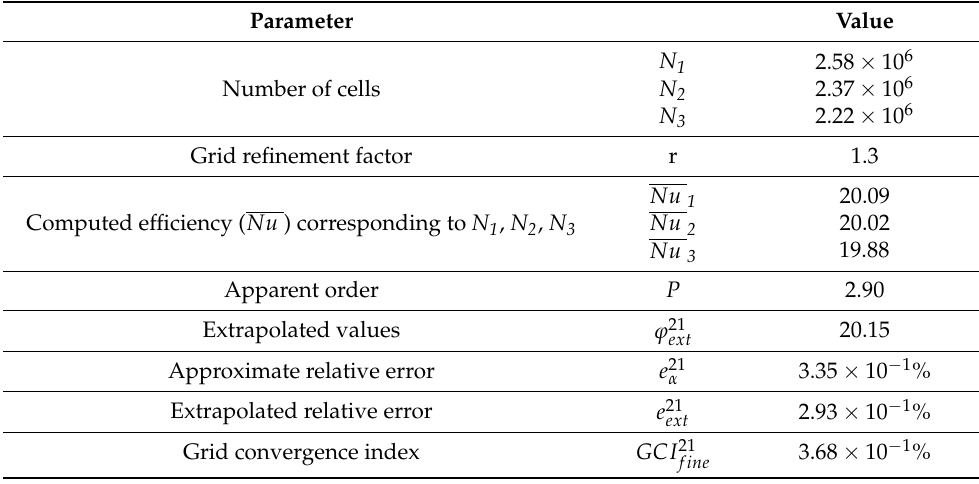
Table 3. Analysis of grid convergence index.